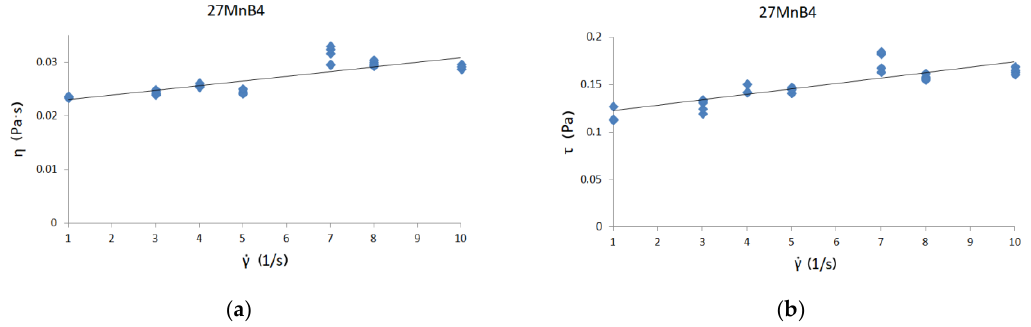
Figure 7. ( a ) Viscosity curve for 27MnB4 steel at 1530 °C; ( b ) flow curve for 27MnB4 steel at 1530 °C.